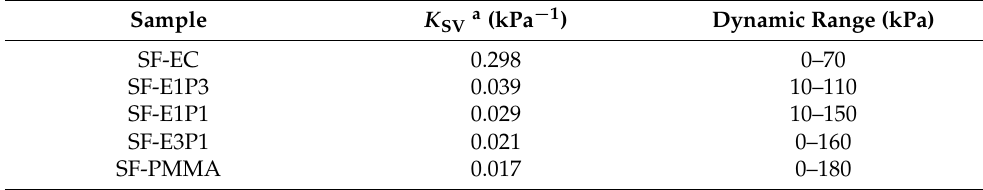
Table 2. Performance characteristics of sensing films with a different matrix.